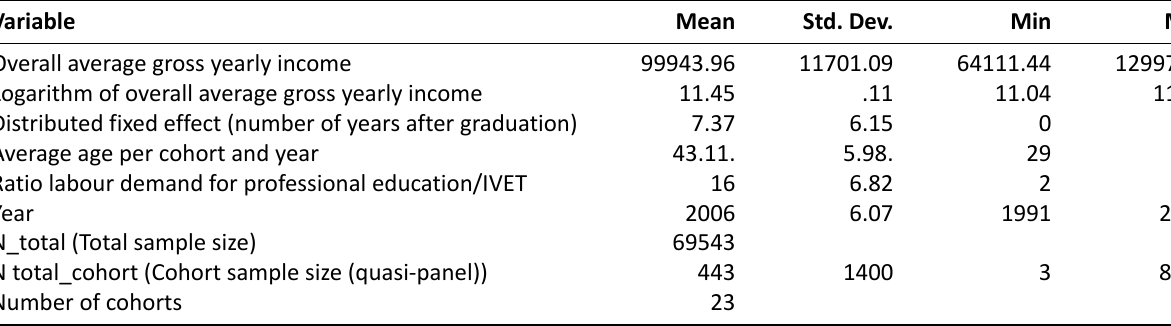
Table 1. Descriptive overview of variables for model I.